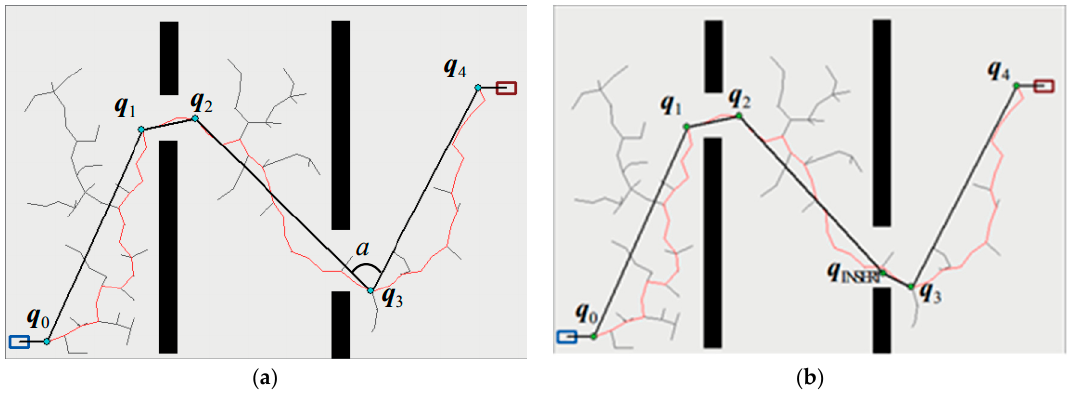
Figure 1. Pruning algorithm diagram. ( a ) Initial paths generated by the S-RRT; ( b ) Smooth paths using Function Pruning( T ).